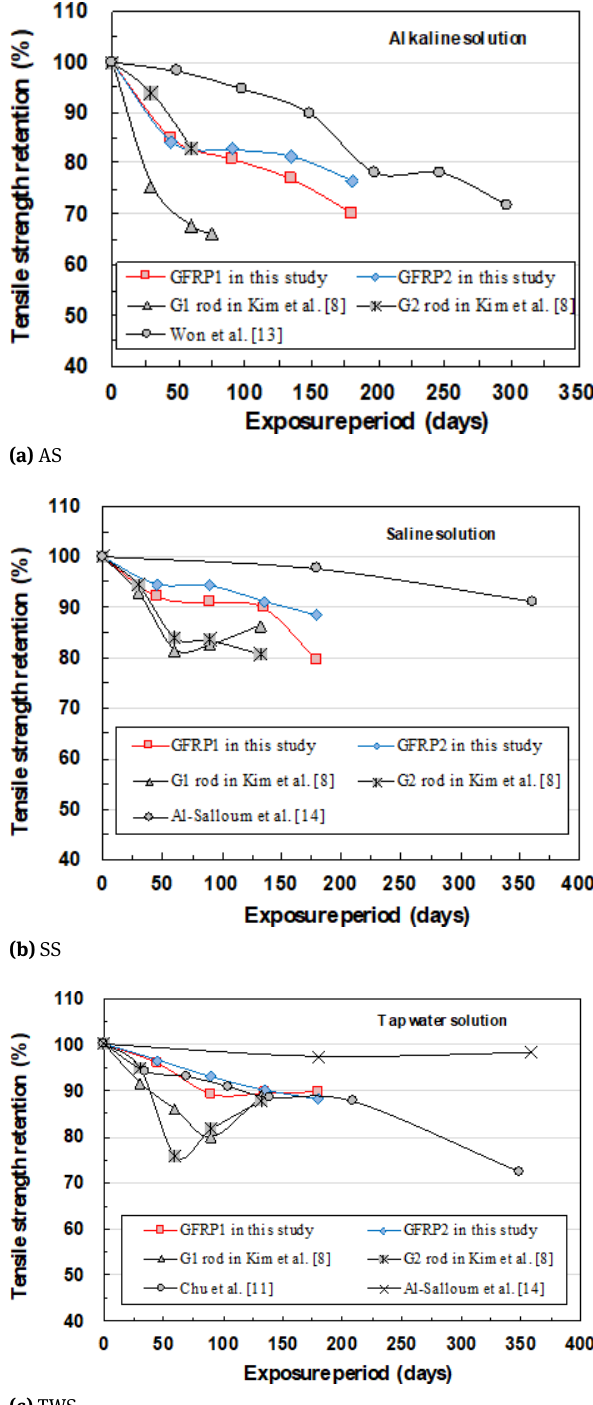
Figure 7: Relationships between tensile strength retention and exposure period of GFRP bars tested in this study and previous